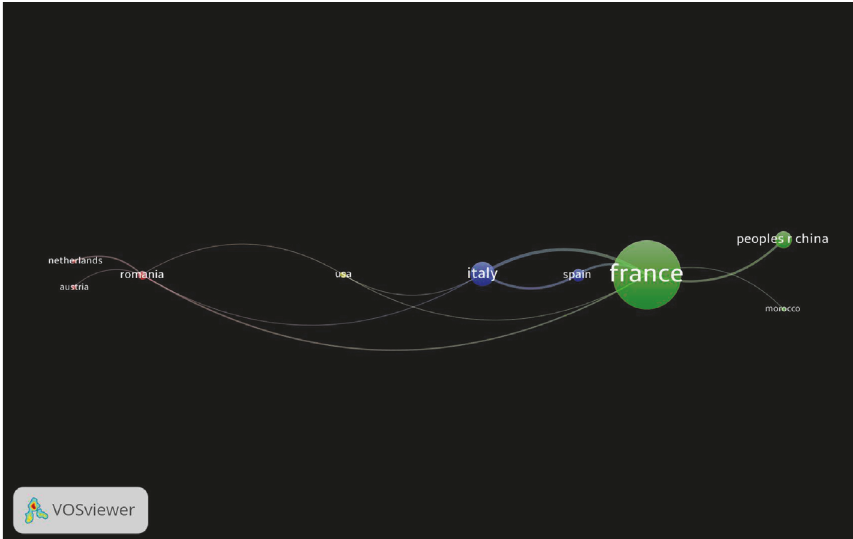
Figure 3: Visualization of international collaboration between countries; the size of the circles represents the collaboration degree, and the width of line illustrates the strength. If a country did not cooperate with other countries to accomplish one of the 100 cited-most articles, it will not be shown in the figure.